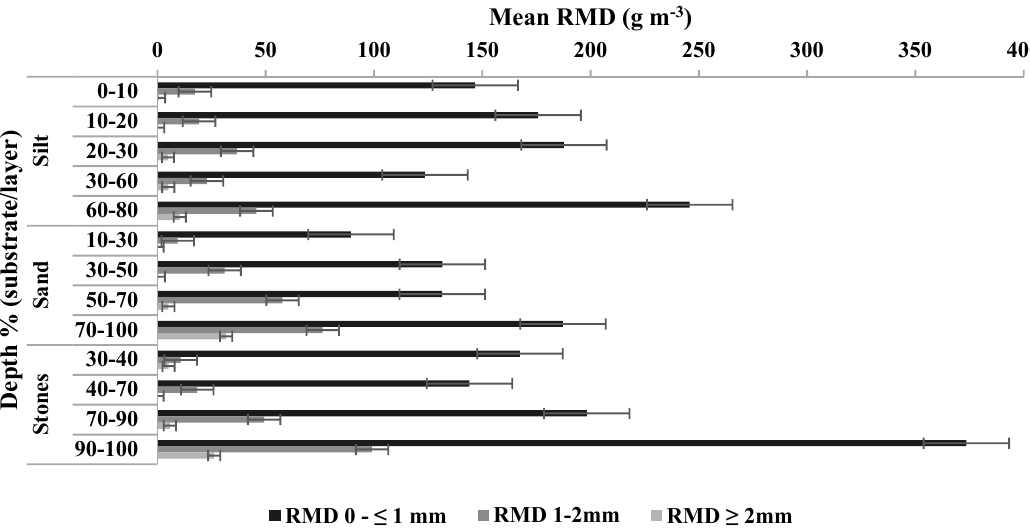
Figure 5. Variation in root mass density (RMD) with depth separated by diameter class and substrate. Depth scale is % (each 10% interval = 7 cm depth from the surface). Error bars are 1 SE.